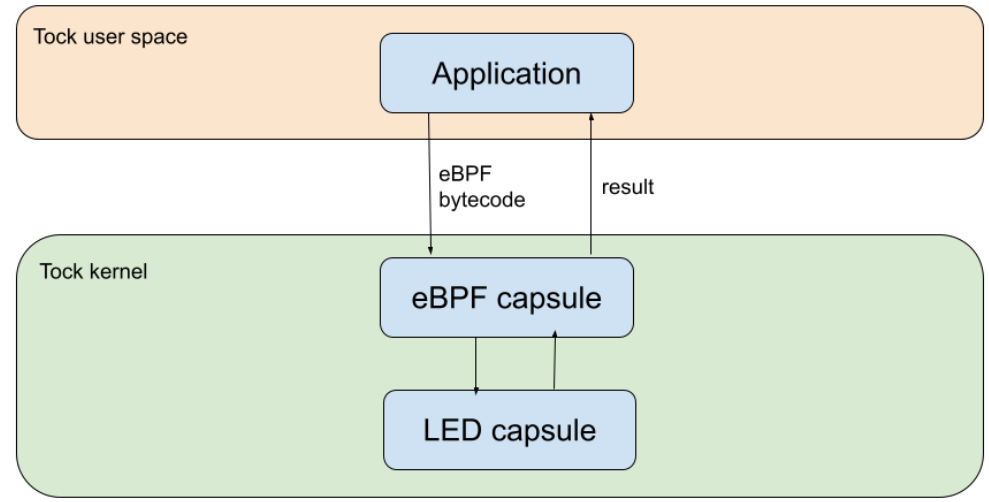
Figure 5. The communication between the application and a peripheral capsule using the eBPF